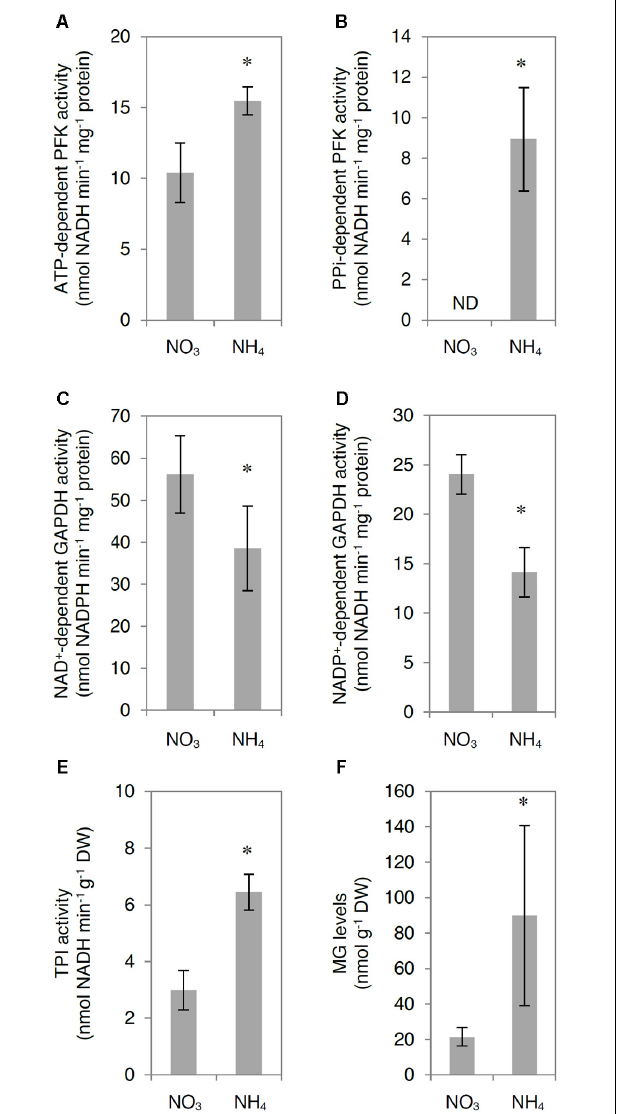
FIGURE 3 | Influence of ammonium (NH 4 + ) nutrition on glycolytic enzyme activity and methylglyoxal (MG) levels. Activity of (A) ATP-dependent phosphofructokinase (ATP-dependent PFK), (B) PPi-dependent phosphofructokinase (PPi-dependent PFK), (C) phosphorylating NAD + -dependent glyceraldehyde-3-phosphate dehydrogenase (NAD + -dependent GAPDH), (D) non-phosphorylating NADP + -dependent glyceraldehyde-3-phosphate dehydrogenase (NAD + -dependent GAPDH), and (E) triosephosphate isomerase (TPI); and (F) MG levels in leaf tissue of nitrate (NO 3 − )-grown and NH 4 + -grown plants. ND, not detectable. Values are the mean ± standard deviation (SD) of 3–4 biological and 2 technical replicates. Significant differences ( P ≤ 0.05) between NO 3 − -grown and NH 4 + -grown plants are indicated by an asterisk ( ∗